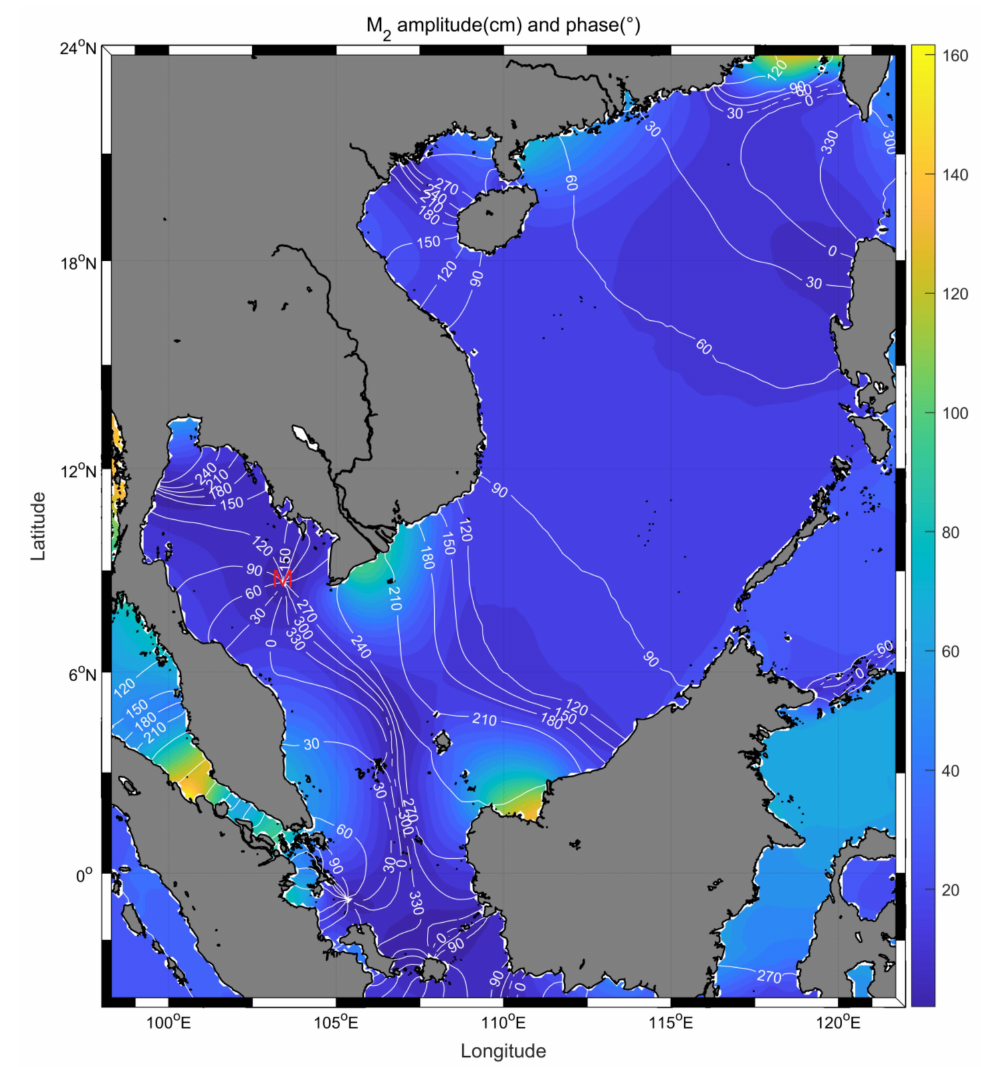
Figure 5. Same as Figure 1, but for the South China